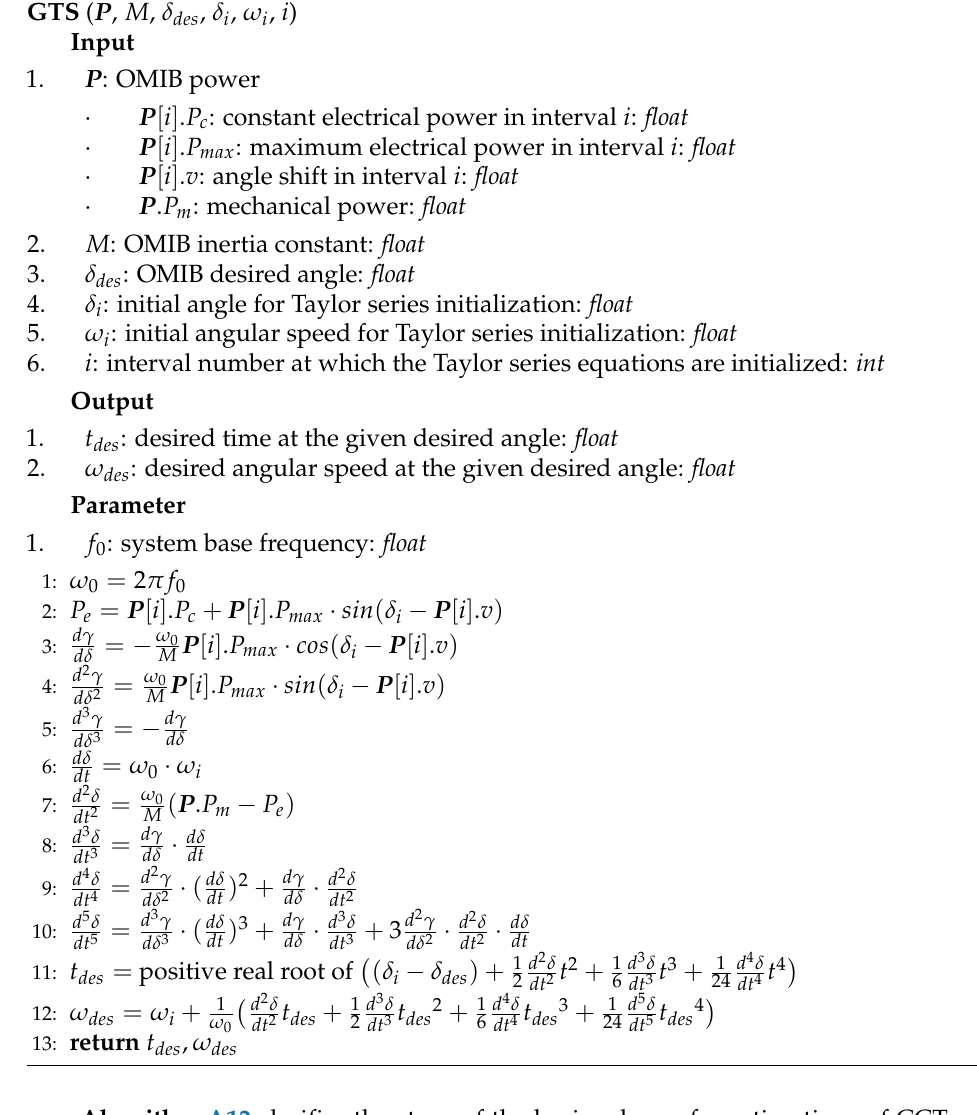
Algorithm A12 clarifies the steps of the basic scheme for estimations of CCT with EEAC. The algorithm inputs the synchronous generators’ data, the admittance matrices, the type of the OMIB equivalent which can be of the ZOOMIB or COOMIB type for the basic EEAC, the type of CMI, and the index of the faulted bus if the CMI criterion is ’composite’. Besides the inputs, the algorithm also requires certain parameters: system base frequency as a constant parameter, and variable parameters including CMI threshold, angle step size, and maximum integration limit for CCA function. The algorithm starts by identifying the critical generators and forming a set of cm CCs (SCC) and a set of NCs (SNC). It then evaluates each pair of CC and NC. For each pair it first forms the pre-fault, during-fault and post-fault OMIB equivalents. The initial angle δ 0 is defined as the intersection point of the pre-fault OMIB electrical power and the mechanical power. Then, the boundaries of the OMIB equivalents of during-fault and post-fault states are set to δ 0 and δ max